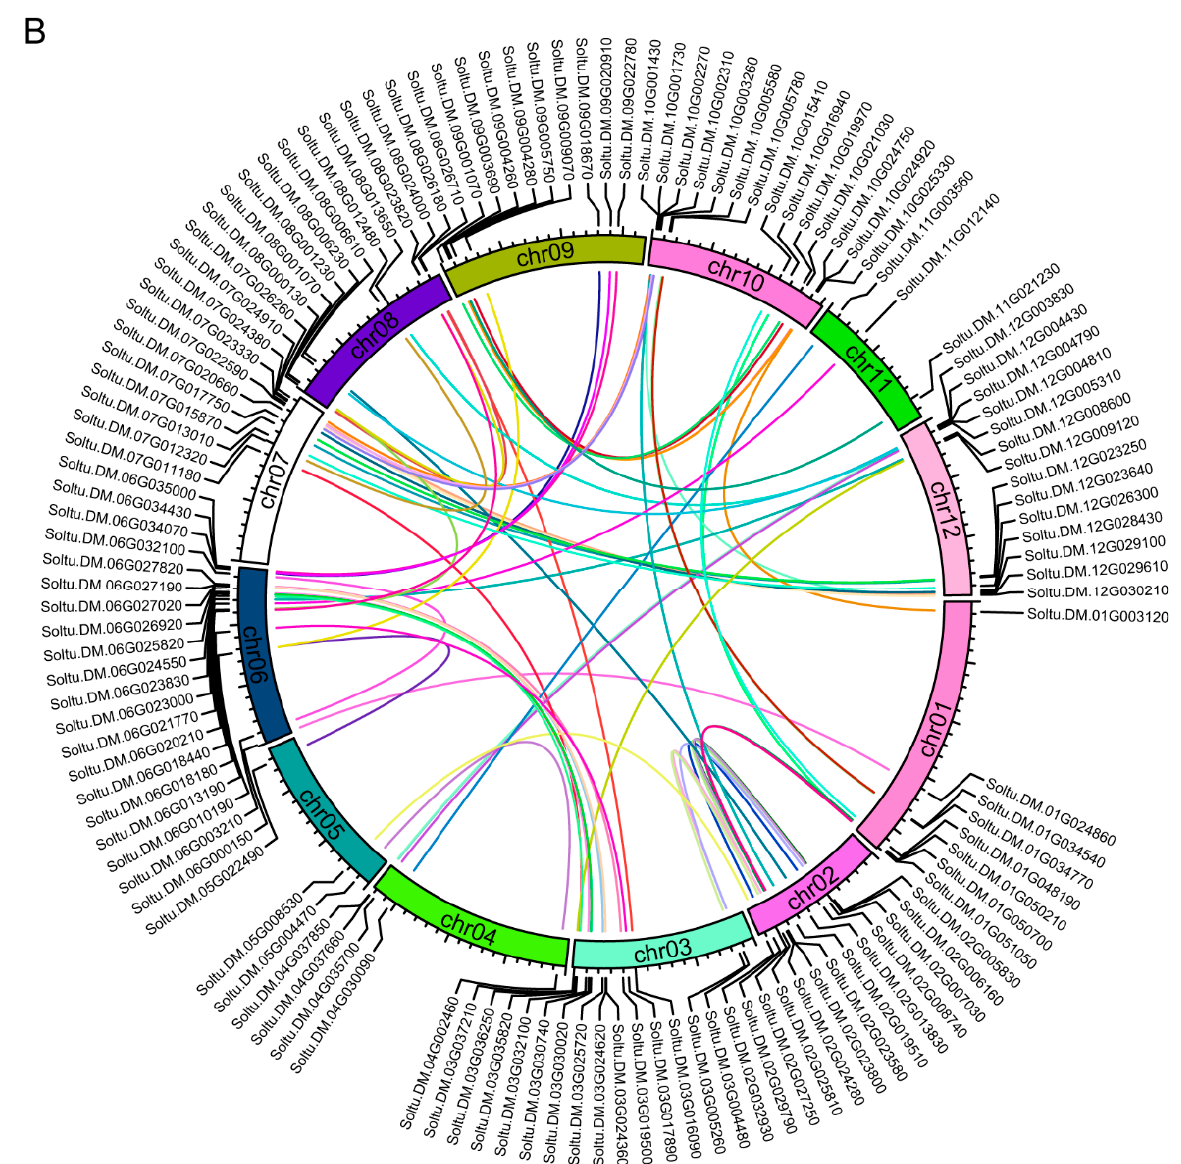
Figure 2. Chromosomal distribution of the identified proteins among nuclear and chloroplast genomes. ( A ) Circos plot represents 12 chromosomal DNA, a scaffold, and a chloroplast genome in a size-specific manner in its outermost peripheral ring. The pink layer and the blue layer indicate the chromosomal region and the number of proteins identified and all potato proteins, respectively, while the innermost circle represents the density of the identified proteins in each chromosome. ( B ) Circos plot shows the chromosomal distribution of duplicated genes encoded in these identified proteins.